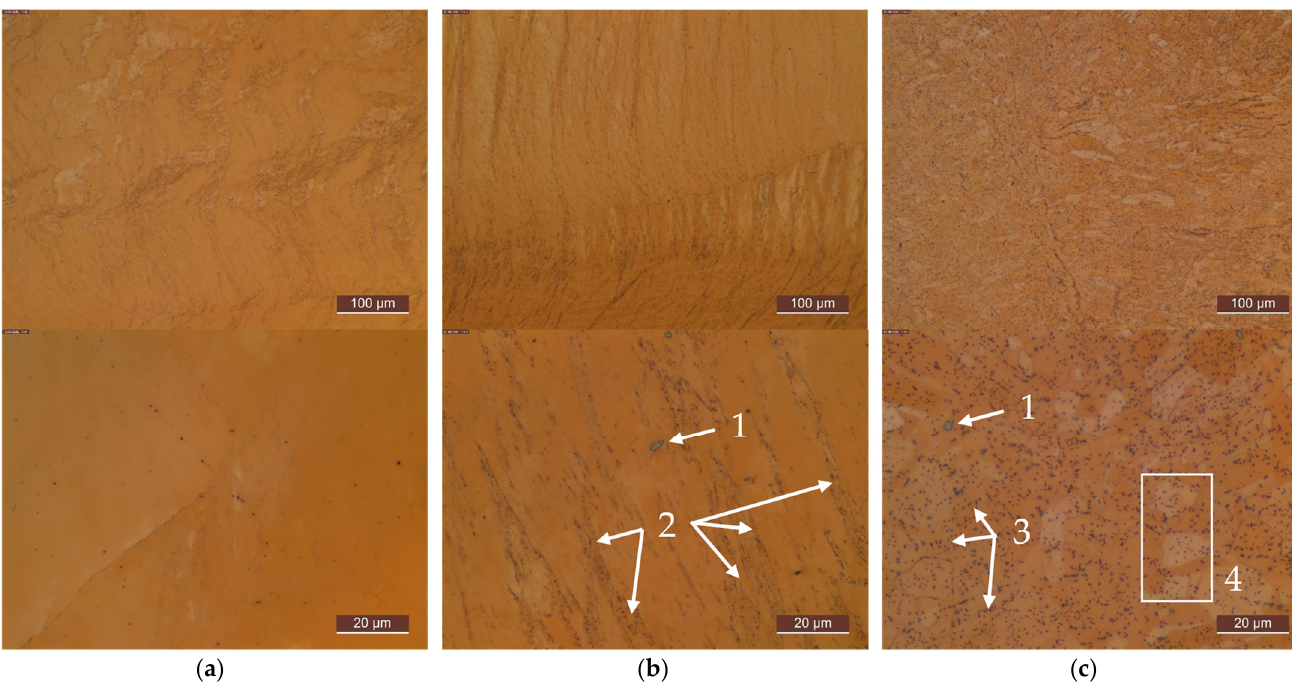
Figure A10. Microstructure evolution of CuHf0.7 during DSC measurements in the optical micro- scope: specimen with prior cold rolling; ( a ) initial state after 75% cold rolling; and after DSC measurement; ( b ) condition 1; ( c ) condition 2; showing undissolved hafnium phase after casting (1), fine precipitates located on slip bands next to dislocations (2), coarsened hafnium precipitates (3), and an area visualizing recrystallization (4).